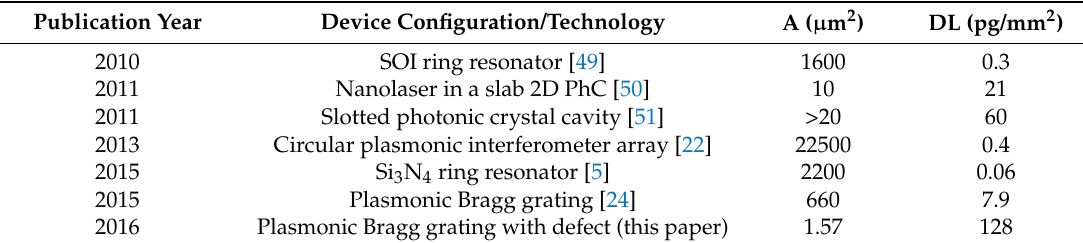
Table 3. State-of-the-art of integrated photonic/plasmonic